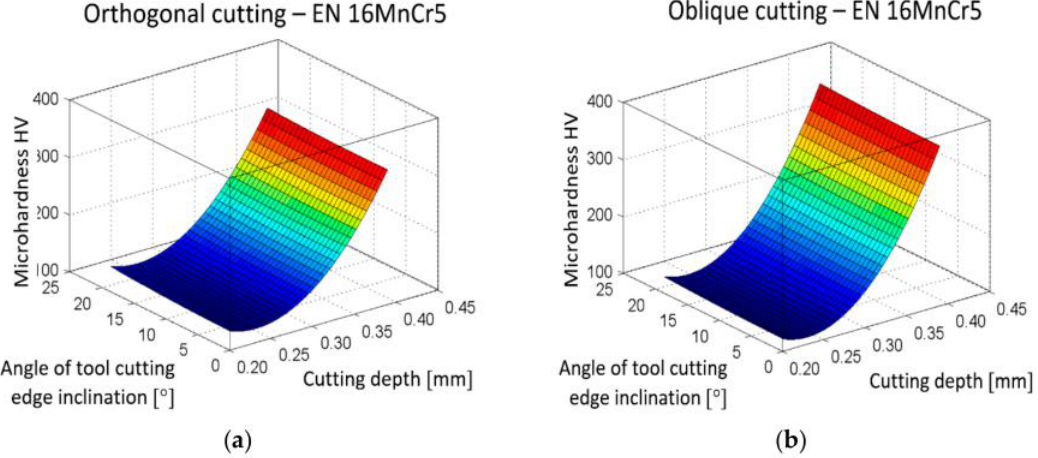
Figure 16. Dependency of microhardness HV on the cutting depth a p and on the angle of tool cutting edge inclination λ s . ( a ) Orthogonal cutting; ( b ) oblique